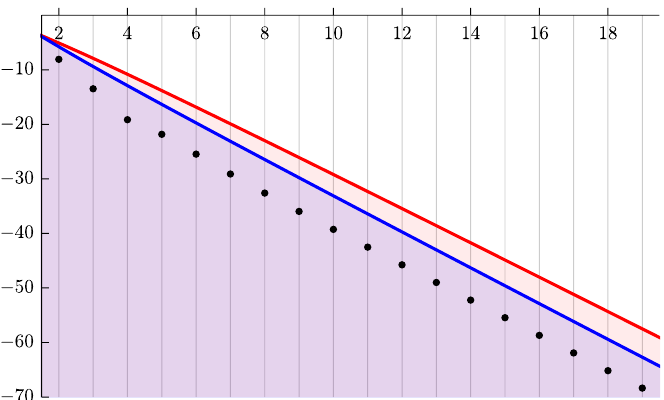
Figure 5 . The univalence bounds on the series coefficients ¯ c n ≥ 2 for the hydrodynamic energy diffusion mode in the linear axion model with m/T = 100 . Black dots represent the logarithms of the absolute values of the numerically computed coefficients, i.e., ln | ¯ c n | . The red line represents the logarithm of the bounds set by the de Branges theorem in eq. (4.19) (i.e., ln n ¯ D/ ¯ R n − 1 ) while the blue line corresponds to the bounds given by the logarithms of the stronger log bounds in eq. (4.20) (i.e., ln 2 ¯ D/n ¯ R n − 1